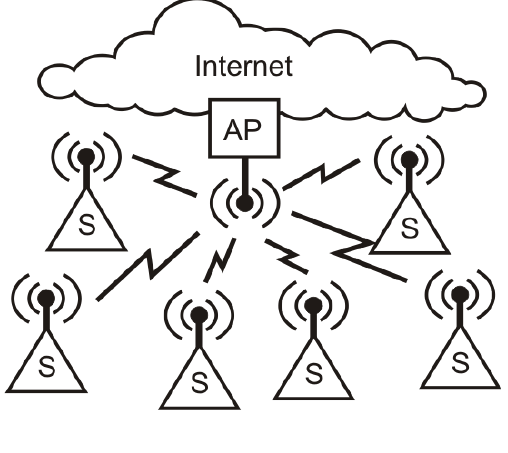
Figure 2. Sensor network. Sensors and actuators are connected to wireless sensor platforms (S). The sensor platforms can advertise their services within the sensor network and on-line as they utilize the Internet Protocol (IPv6). All on-line traffic is routed through the access point